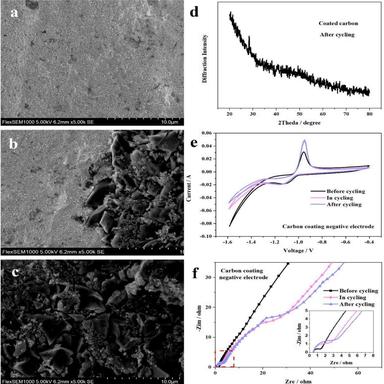
(a-c) SEM images of the lead paste, carbon coating negative electrode and coated carbon. (d) XRD diagram of coated carbon. (e) and (f) CV diagram and Nyquist diagram of the carbon coating negative electrode.